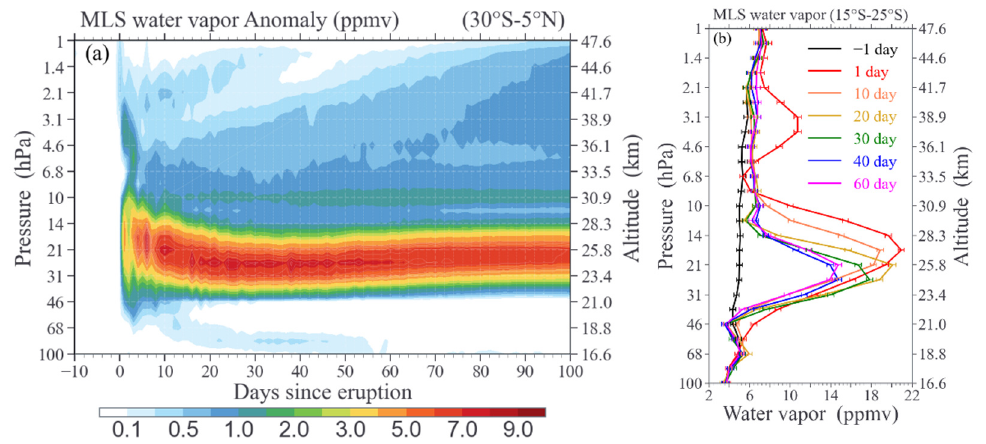
Figure 2. ( a ) MLS/Aura time series of mean (30 ◦ S–5 ◦ N) stratospheric water vapor anomalies (ppmv) from 100 to 1 hPa after the Tonga eruption (15 January 2022), during January–April 2022. The anomalies are calculated by subtracting water vapor averaged 0–10 days prior to the eruption of Tonga from daily water vapor data. ( b ) Stratospheric water vapor profiles on various days following the Tonga eruption. A narrower latitude range (15 ◦ –25 ◦ S, closer to Tonga) was chosen to highlight the effect of the eruption.